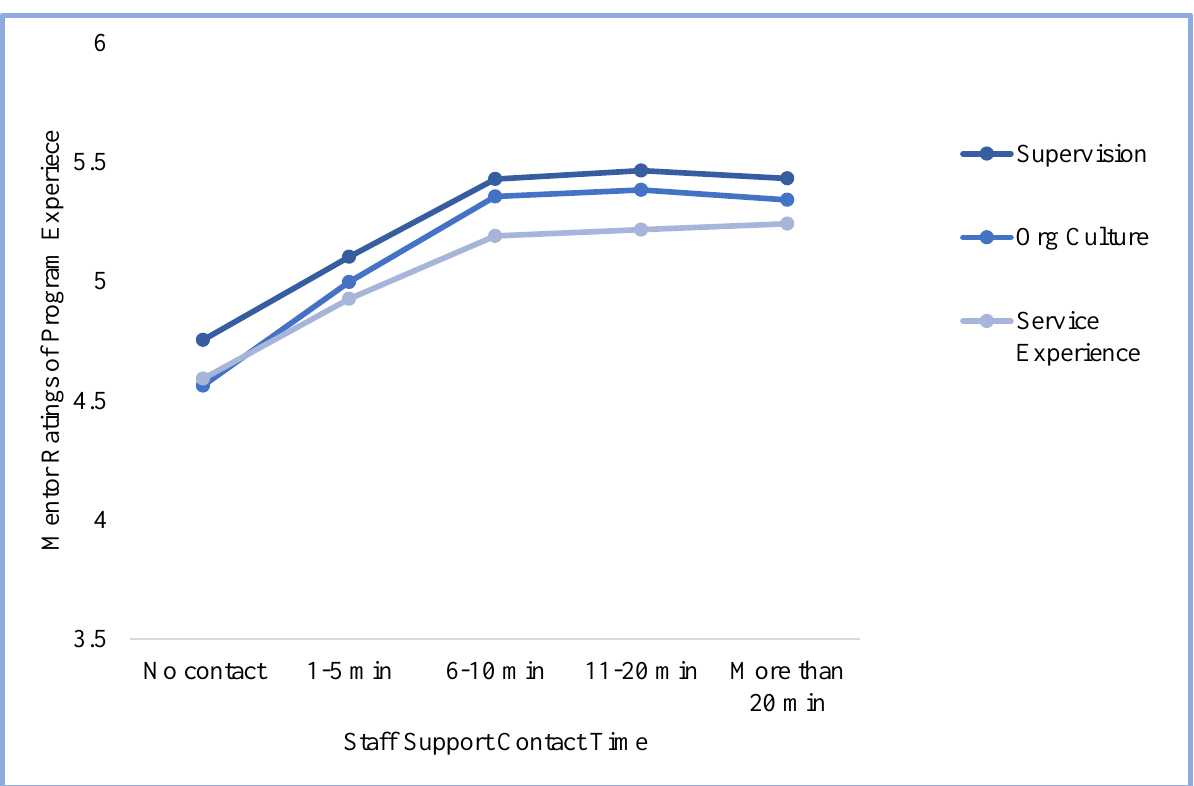
Figure 1. Mean Ratings of Mentor Volunteer Experiences by Staff Support Contact